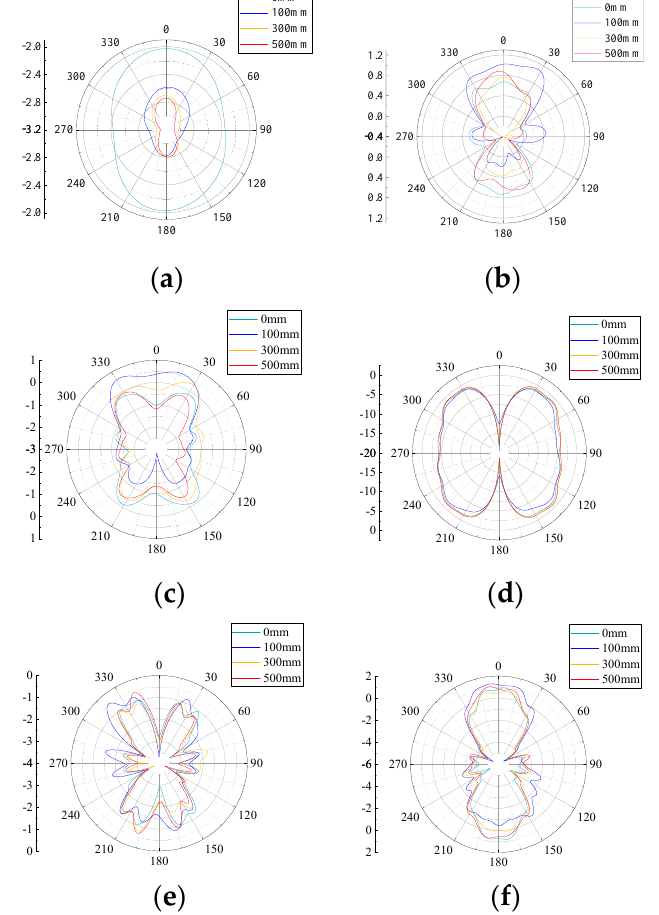
Figure 12. E-plane patterns at different frequencies: ( a ) 0.5 GHz; ( b ) 1 GHz; ( c ) 1.5 GHz; ( d ) 2 GHz; ( e ) 2.5 GHz; and ( f ) 3 GHz.